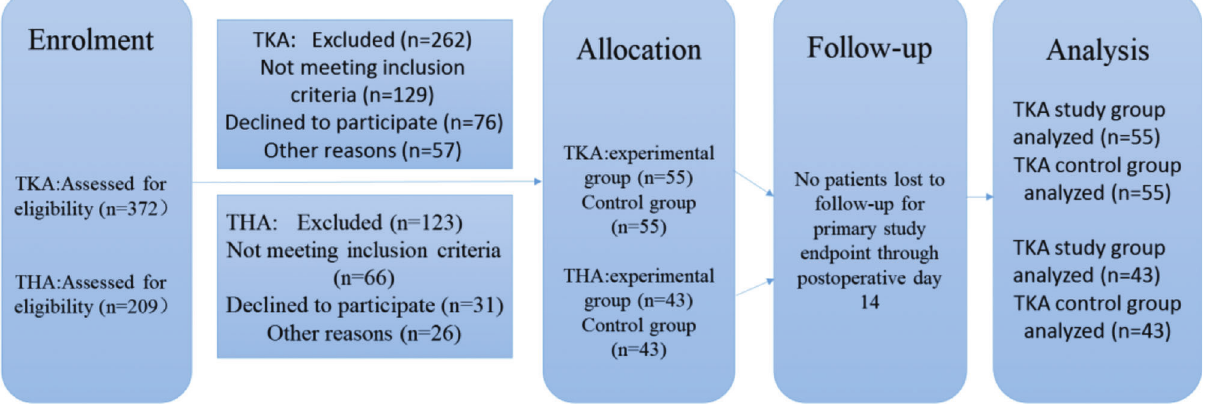
Figure 1 - Subject inclusion decision